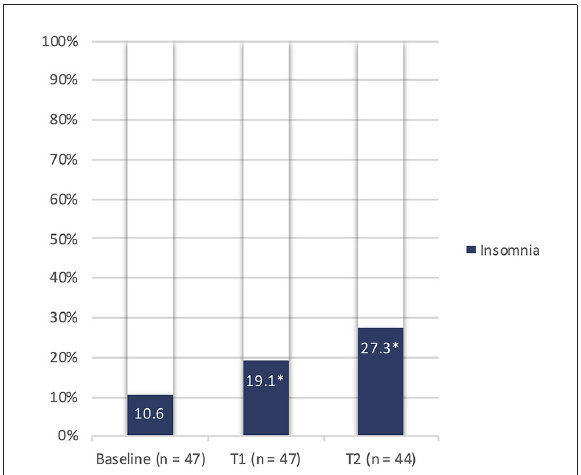
FIGURE1 Prevalence of insomnia before and after COVID-19 in the study population. n, number; T1, 2-month study visit; T2, 10-month